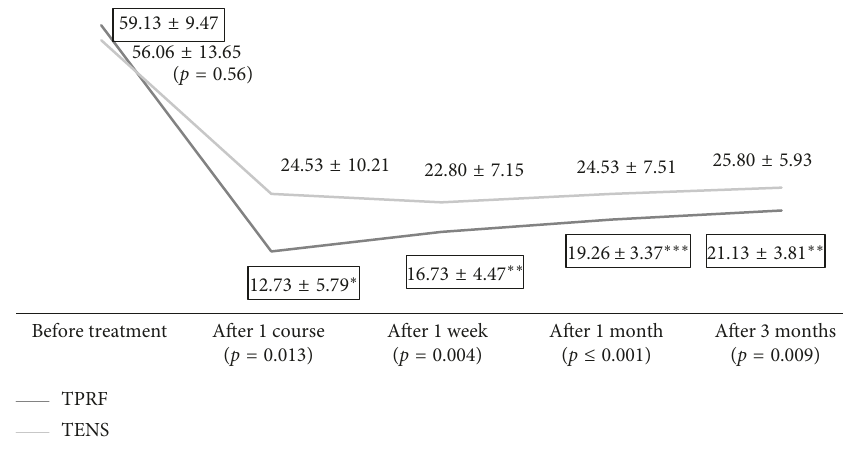
Figure 4: PEG score with TPRF and TENS group.